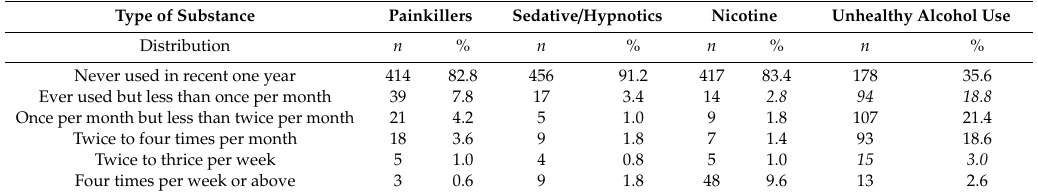
Table 1. Distribution of and frequency of painkillers, sedative / hypnotic drugs, nicotine, and unhealthy alcohol use among 500 participants.